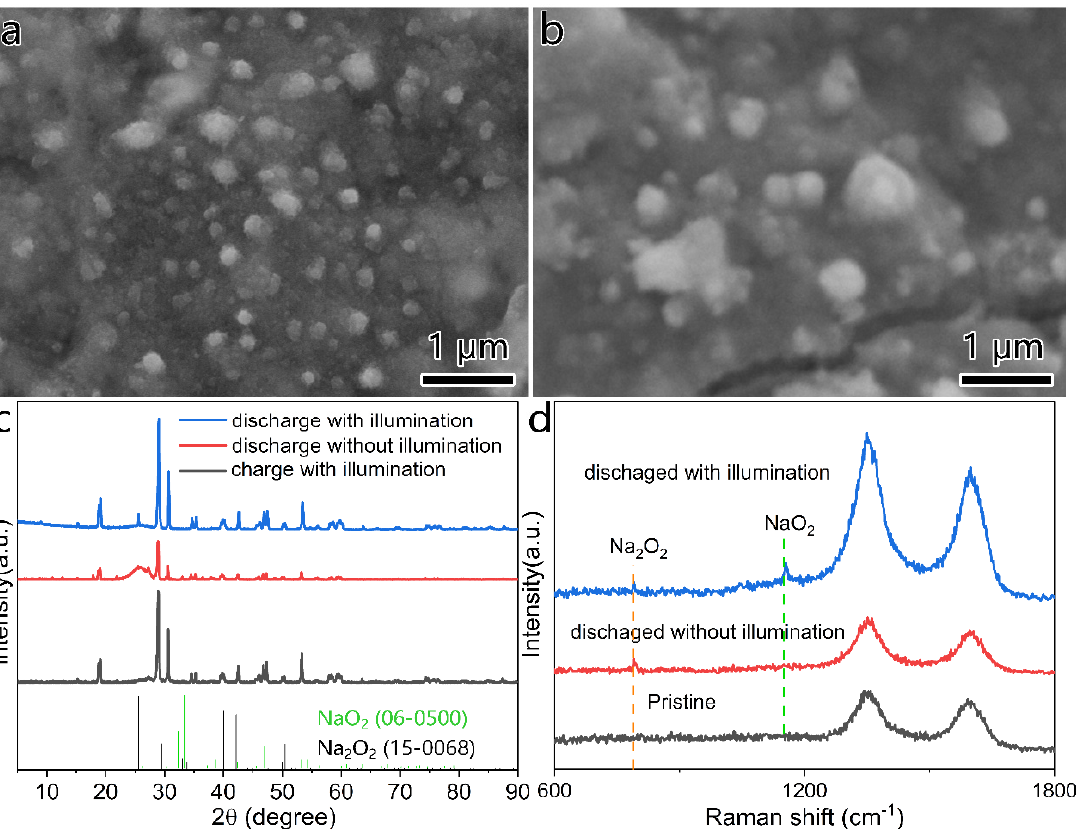
Figure 4. SEM images for the discharged BV–6 cathode under ( a ) illumination, ( b ) no illumination; ( c ) XRD patterns; ( d ) Raman spectra for the BV–6/CNTs cathode operated in Na–O 2 batteries.